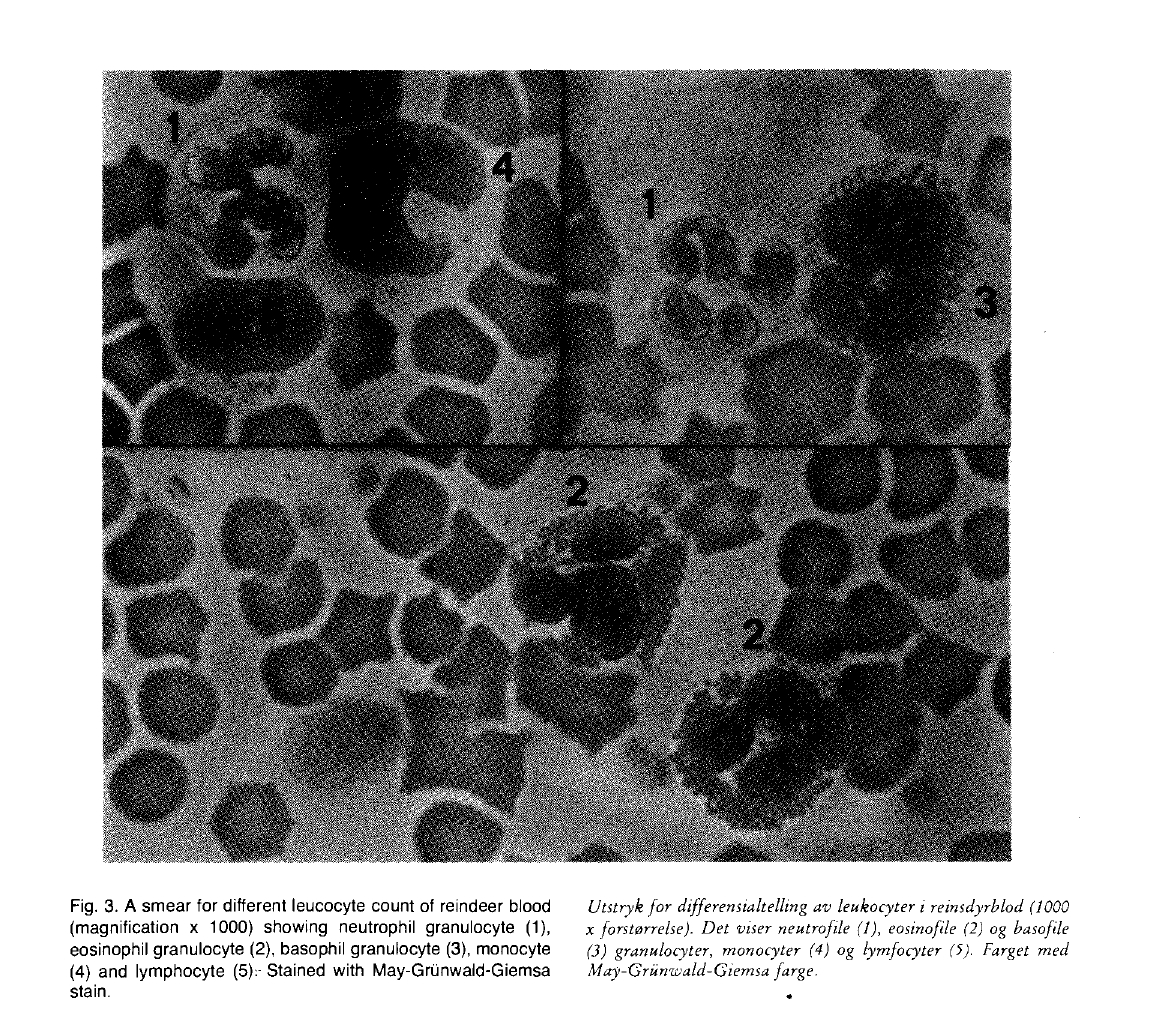
Utstryk for differensialtelling av leukocyter i reinsdyrblod (1000 x forstørrelse). Det viser neutrofile (1), eosinofUe (2) og basofile (3) granulocyter, monocyter (4) og lymfocyter (5). Farget med May-Grunivald-Giemsa